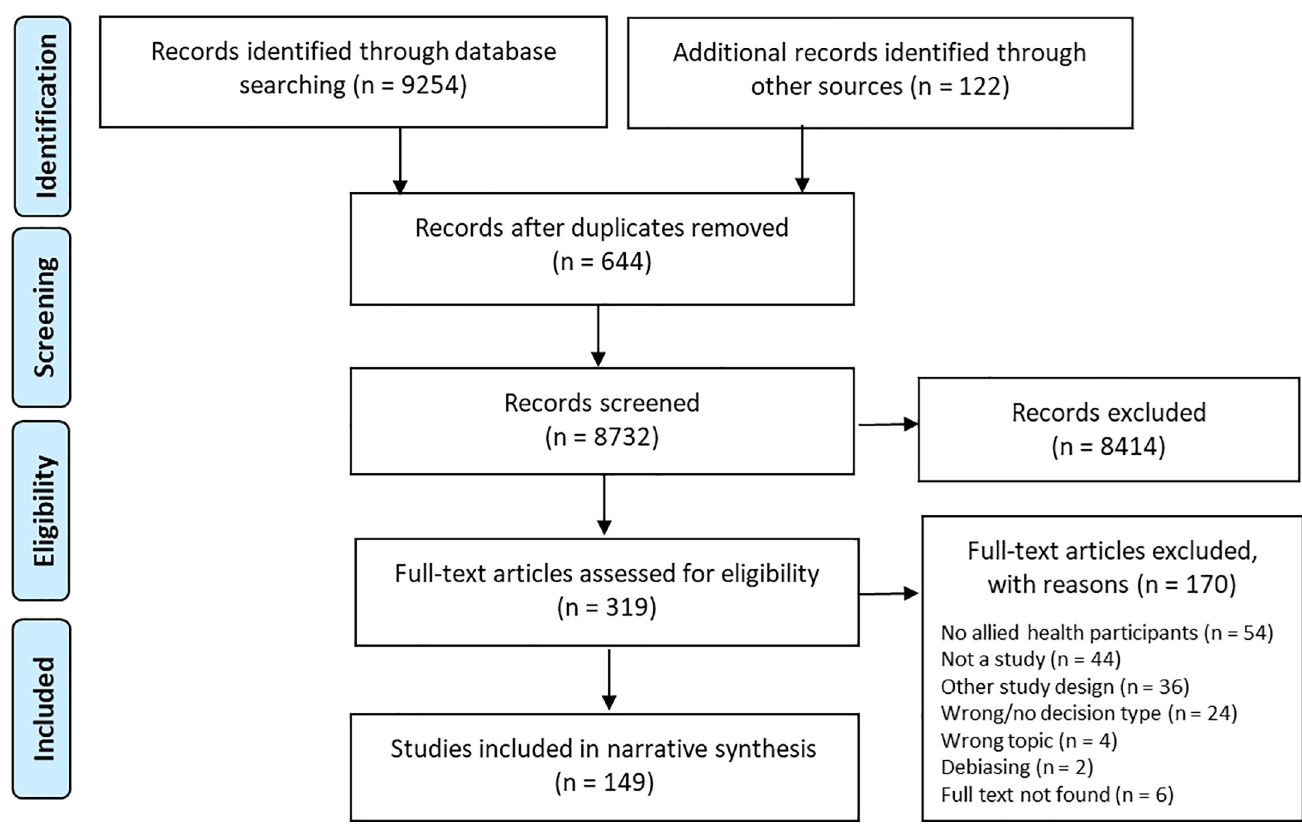
Fig 1. PRISMA flow diagram reporting the electronic database search, screening and study selection